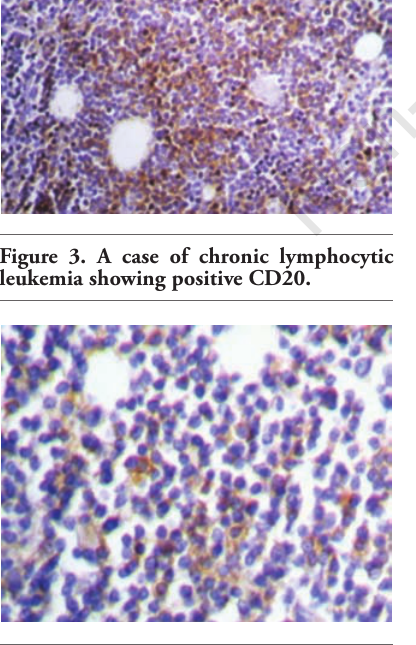
Figure 8. A case of Diffuse large B-cell lym- phoma showing positive